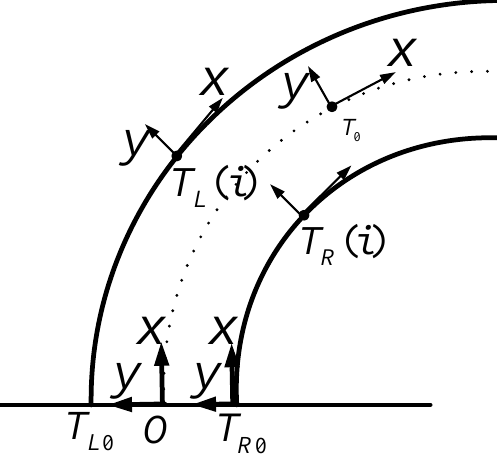
Figure 5. Definition of track coordinate